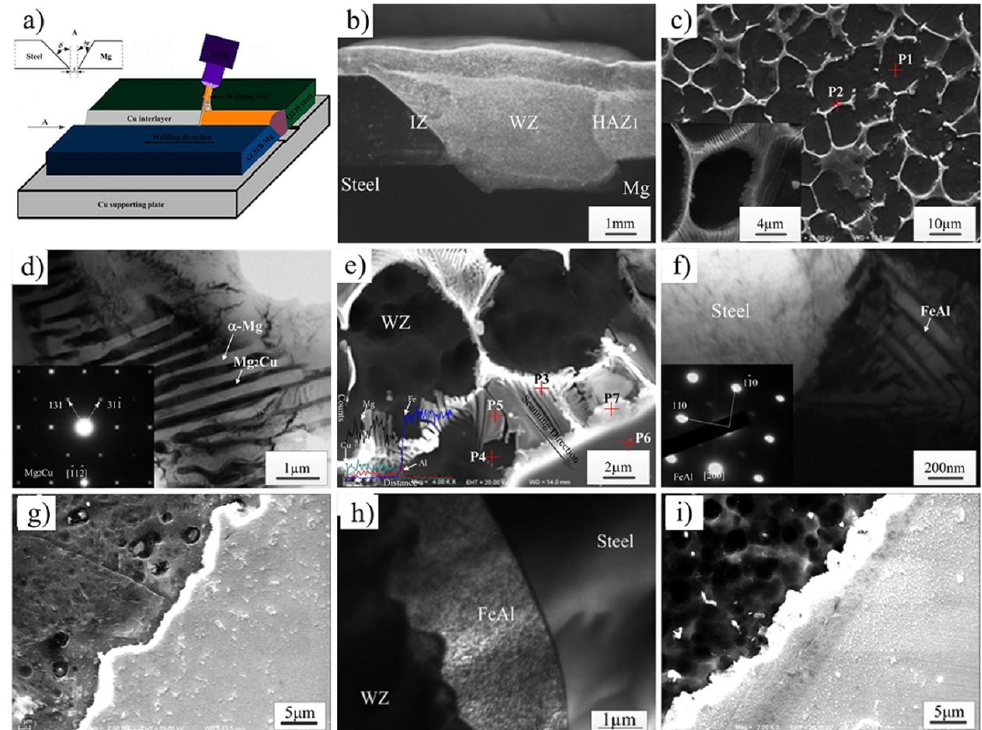
Figure 16. MIG welding process [53–55] ( a ) schematic diagram for Cu interlayer added; ( b ) cross-section of joint with 0.1 mm Cu; ( c – f ) microstructure of weld seam, eutectic structure, interfacial microstructure and reaction layer close to steel in ( b ), respectively; ( g ) interfacial microstructure for AZ31 filler wire added; ( h ) Mg/steel interface TEM image near in ( g ); ( i ) interfacial microstructure for AZ31 filler wire added.